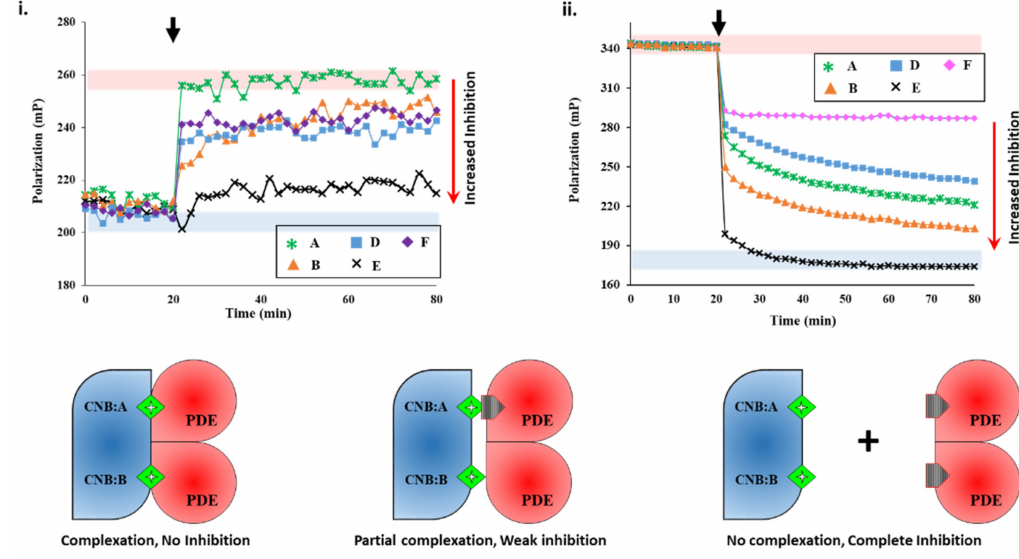
Figure 2. Plant extracts inhibit PDE8 and RegA with different potencies. ( i ) Changes in fluorescence polarization ( y -axis) over time ( x -axis) are represented for 2fluo-cAMP-saturated PKAR upon addition of PDE8c pre-incubated with extracts A (green asterisk), B (orange triangles), D (blue squares), E (black cross), and F (lilac diamonds) at 20 min (black arrow). ( ii ) FP plot showing effect of inhibitors on RegA-R D complexation. After 20 min (black arrow), 5 µ L of extracts A, B, D, E, and F were added to preformed 2fc-R D -RegA complex. Red area indicates zone of no PDE inhibition as per negative control without any extract added, while blue area indicates high PDE inhibition zone using PDE inhibitors as positive control. (C) 2fluo-cAMP (green diamond) is bound to cyclic nucleotide binding (CNB) domains CNB:A and CNB:B of PKA (blue). Cartoons showing inhibitor (gray pentagon) mediated complete (left), partial (center), or no (right) complex formation between PDE (red) and PK (blue) due to no, partial, or complete PDE inhibition, respectively.